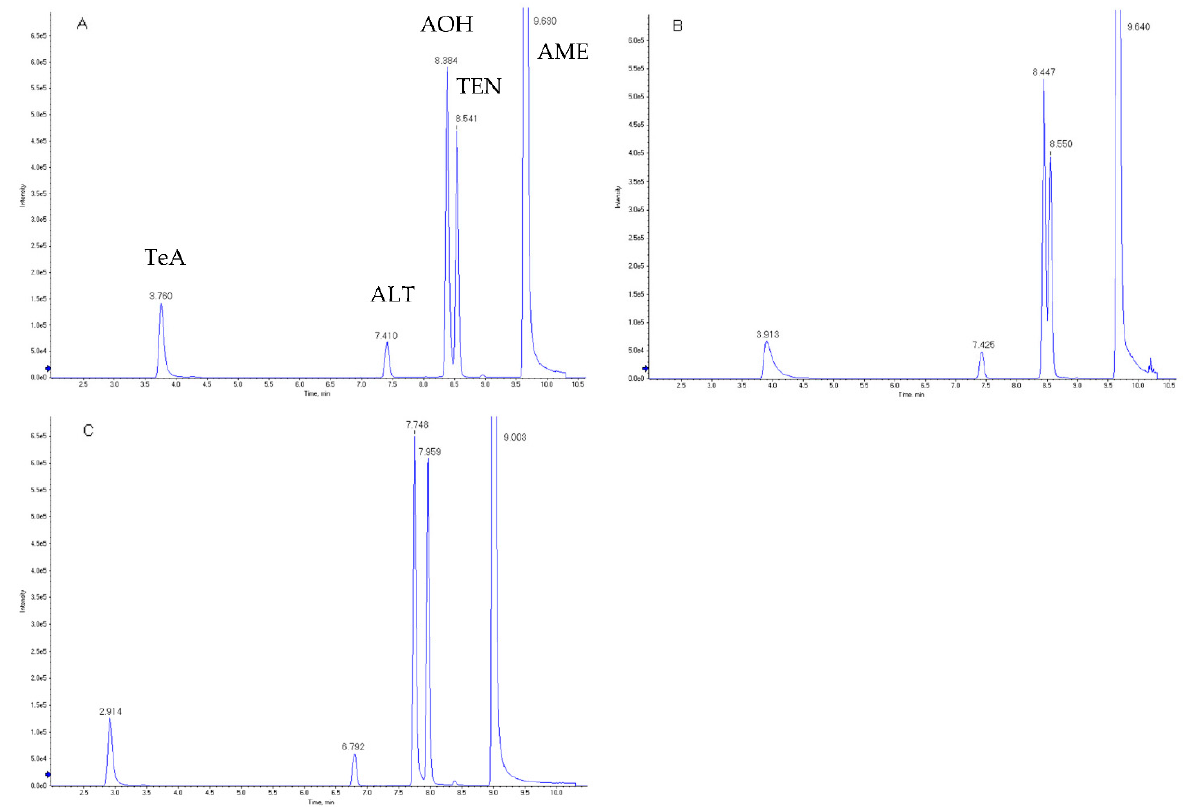
Figure 1. Chromatograms of a solution of Alternaria toxins at 50 µg/L obtained with the analytical